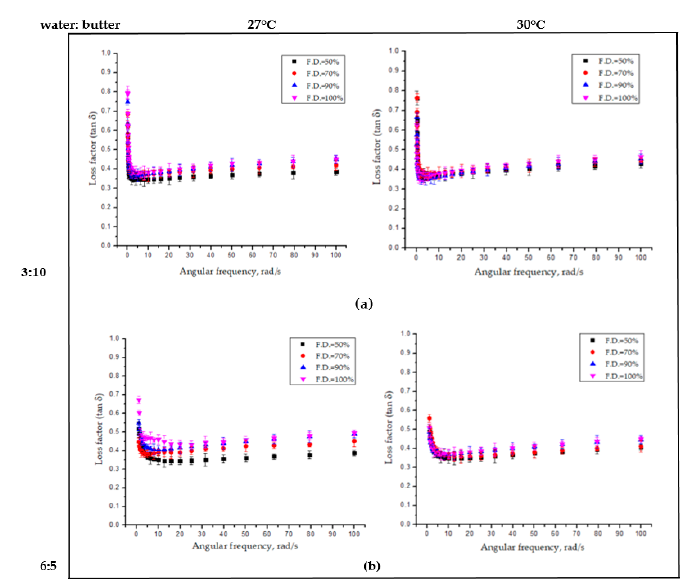
Figure 5. Loss factor (tan δ ) versus frequency of 3D-printed dough structure at different water ratios: ( a ) 3:10 and ( b ) 6:5 at 27 °C and 30 °C, respectively.